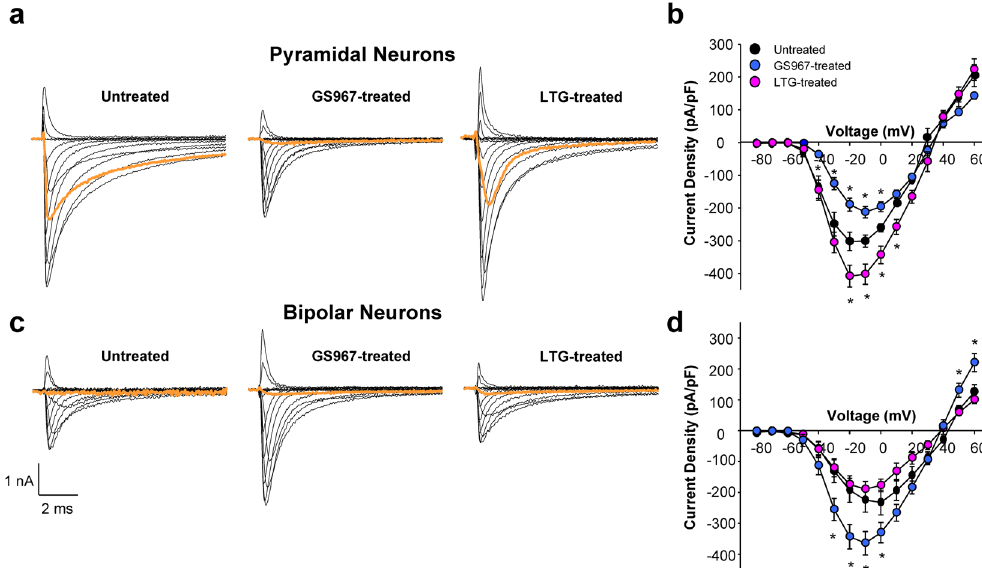
Figure 4. Chronic GS967 treatment of Scn1a + / − mice alters neuronal sodium current density. Representative traces of whole-cell sodium current from ( a ) pyramidal neurons or ( c ) bipolar neurons from untreated ( left ), GS967-treated ( middle ) and LGT-treated ( right ) Scn1a + / − mice. Peak sodium current density (normalized to cell capacitance) at tested potentials from ( b ) pyramidal neurons or ( d ) bipolar neurons from treated and untreated Scn1a + / − mice. Orange traces represent sodium current elicited by a − 40 mV tested pulse, near the action potential threshold potential. Error bars represent SEM, with n = 7–16 per group ( * p < 0.05 for comparison with untreated mice; one-way ANOVA followed by Tukey’s